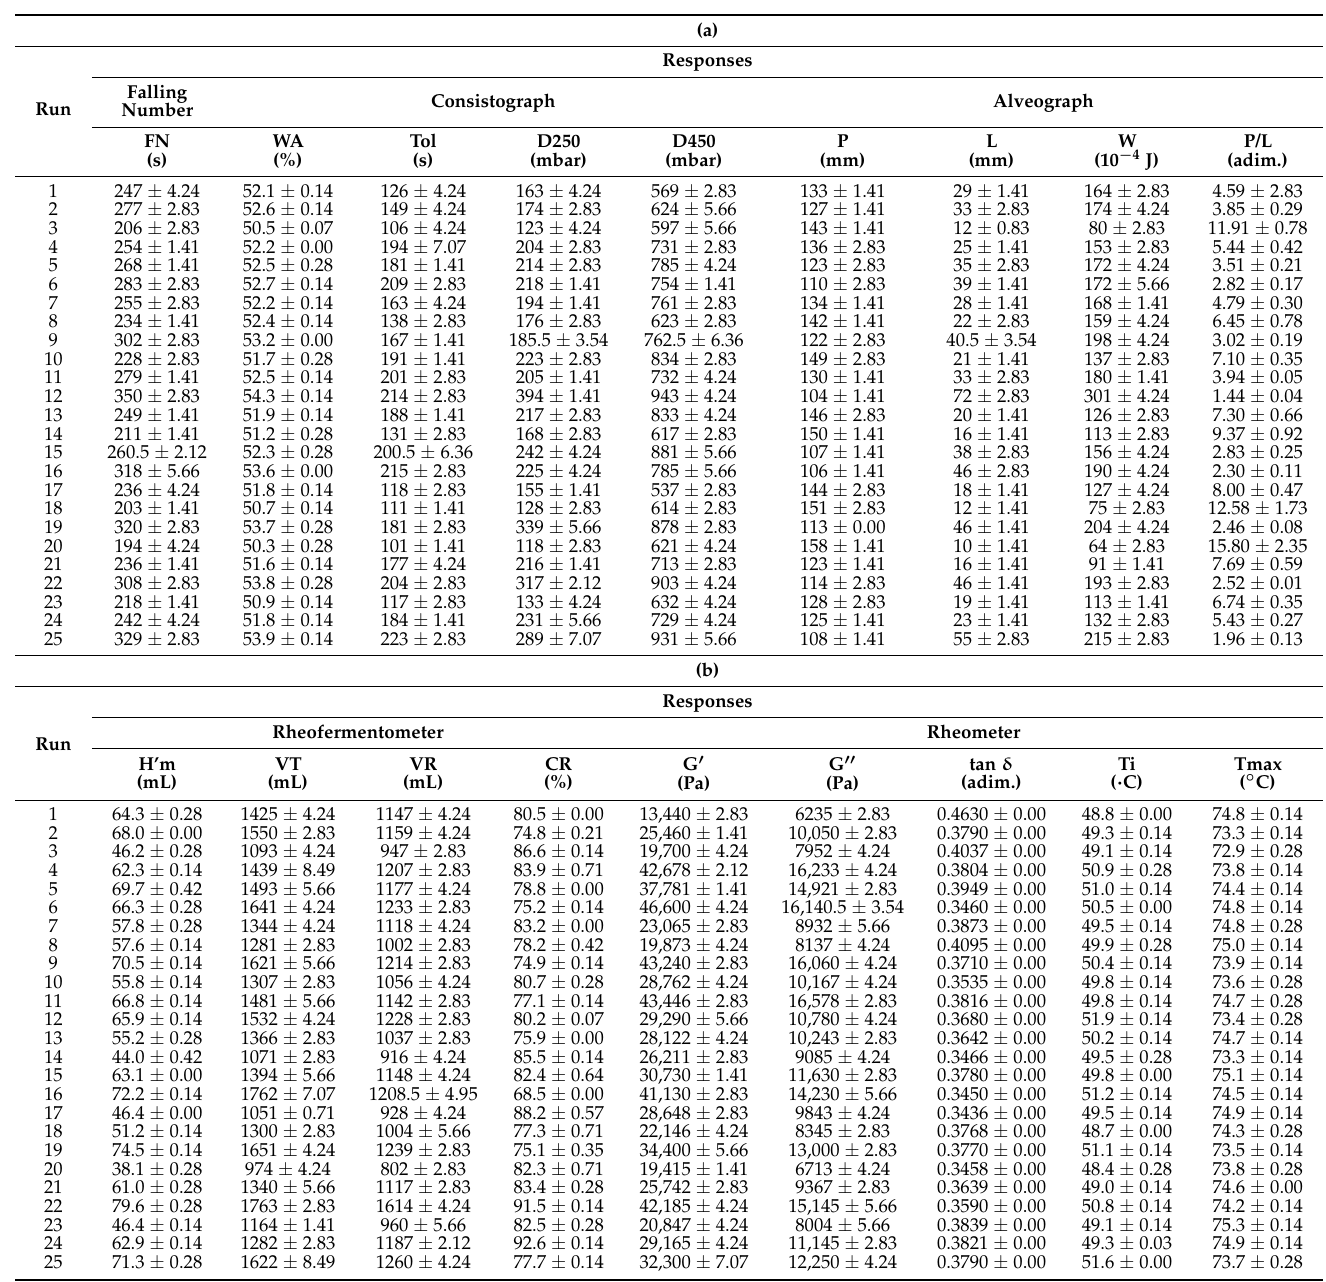
Table 1. ( a ). Effects of CGF and LGF on falling number and dough consistograph and alveograph parameters. ( b ). Effects of CGF and LGF on dough properties during fermentation and dynamic